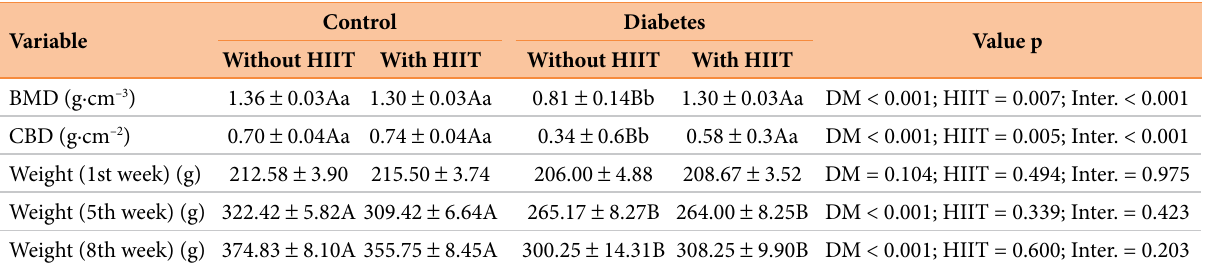
Table 1 - Results of the assessment of the effect of diabetes and HIIT, as well as the interaction between these factors, in relation to the variables evaluated in this